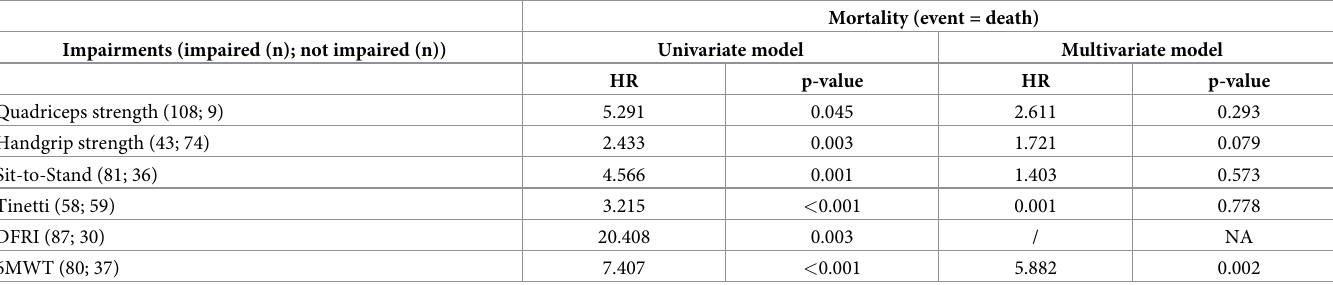
Table 3. Unadjusted competing risks regression model for mortality by the presence of impairments in physical